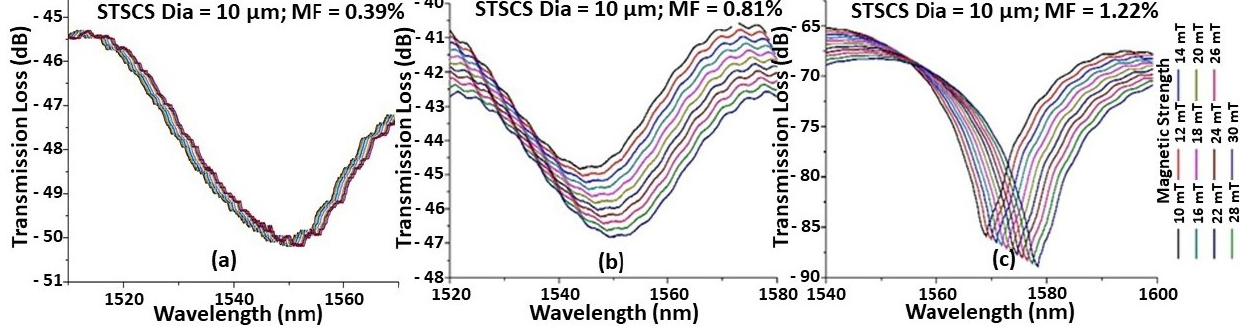
Figure 2. Example of spectral response observed while increasing the magnetic field around a 10 μm waist diameter STSCS optical fibre magnetic field sensor, surrounded by MF with ( a ) 0.39%, ( b ) 0.81%, and ( c ) 1.22% FMPs.